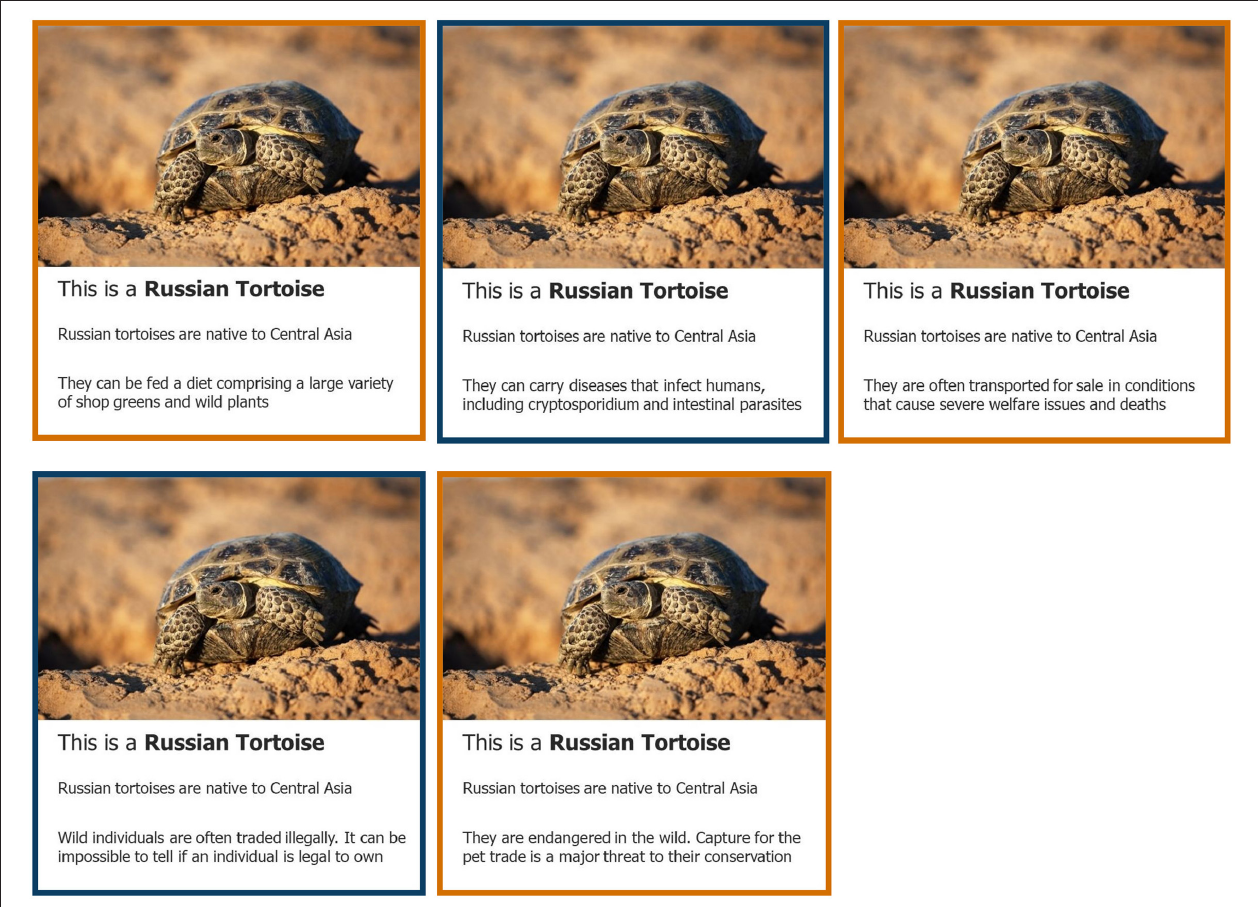
FIGURE 1 | An example set of control and treatment statements for one species, the Russian tortoise, Testudo horsfieldii . From left to right, top to bottom are control, disease, welfare, legality, and conservation information statements.